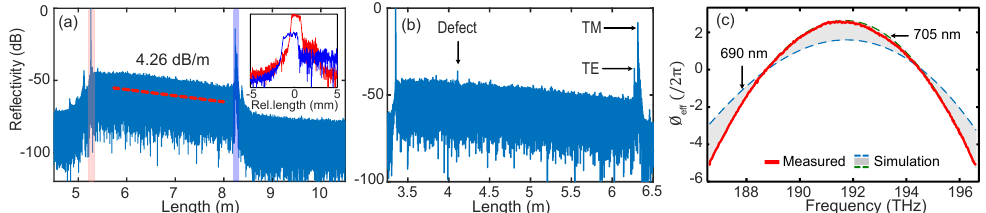
Figure 12. OFDR of the waveguides. ( a ) Spatial reflectivity of fundamental quasi-TE mode (inset: magnification of reflection peaks). ( b ) Spatial reflectivity of fundamental quasi-TM mode. The waveguides are identical in geometry but configured with different fiber delay lengths. ( c ) TE mode measured and simulated effective phase response plot normalized by 2 π